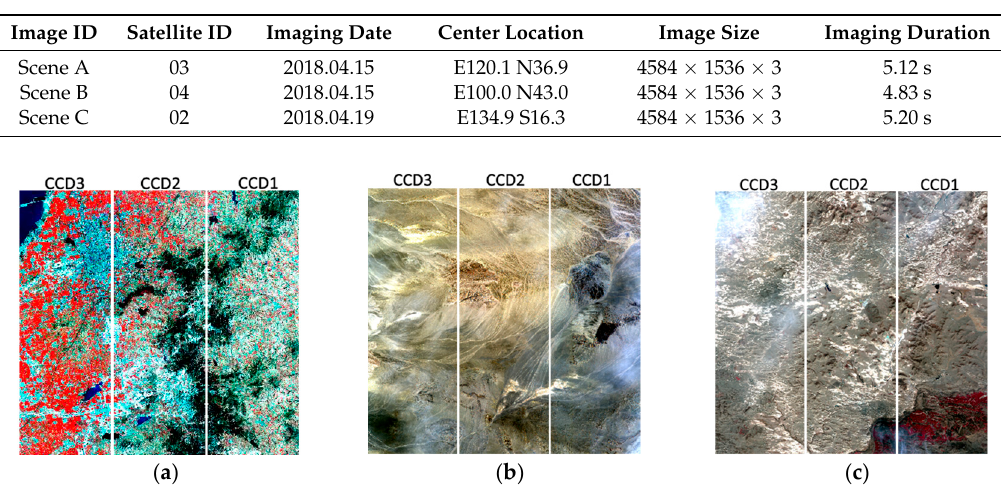
Figure 5. Parallax images between B1 and B2 along the track ( a ) Scene A, ( b ) Scene B, and ( c ) Scene